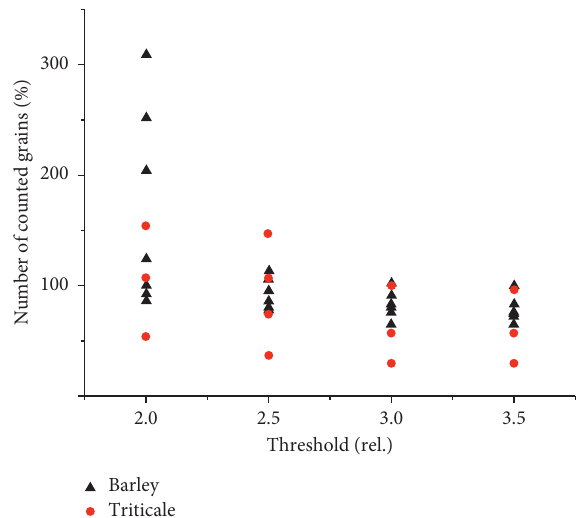
Figure 12: Distribution of algorithm results based on repeated experiments using both barley and Triticale versus threshold values. With threshold values below 2.5 the number of false counts can be as high as 300%. Similarly, when the threshold is over 3, numerous hits are